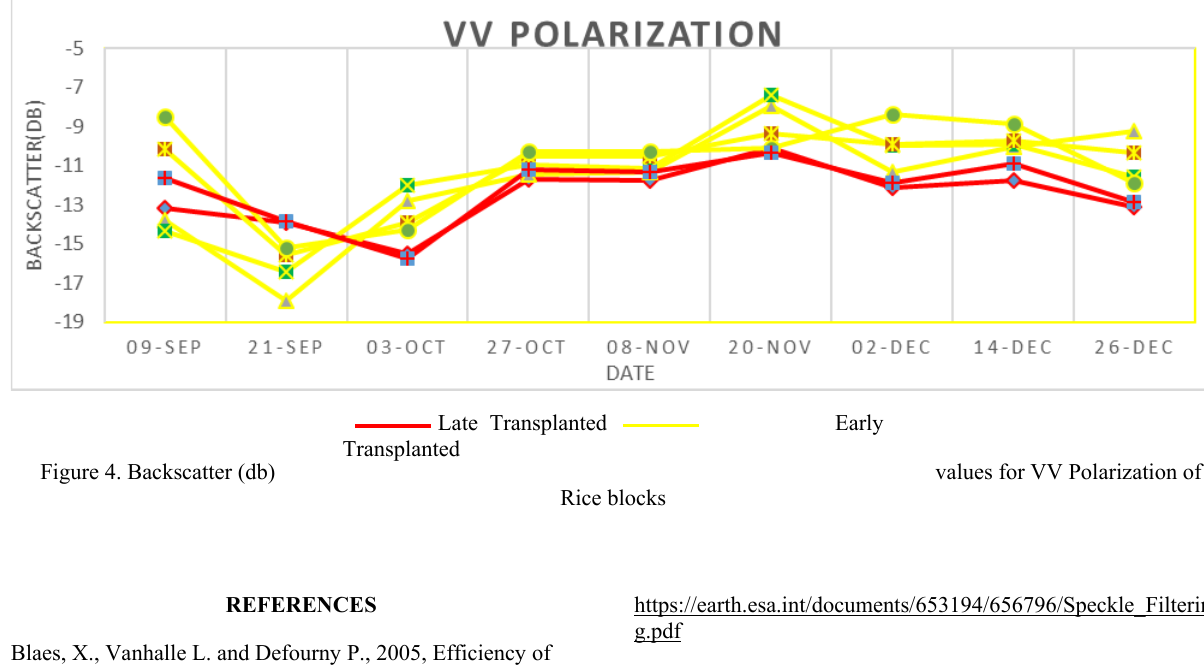
Figure 3. Backscatter (db) values for VH Polarization of Rice blocks